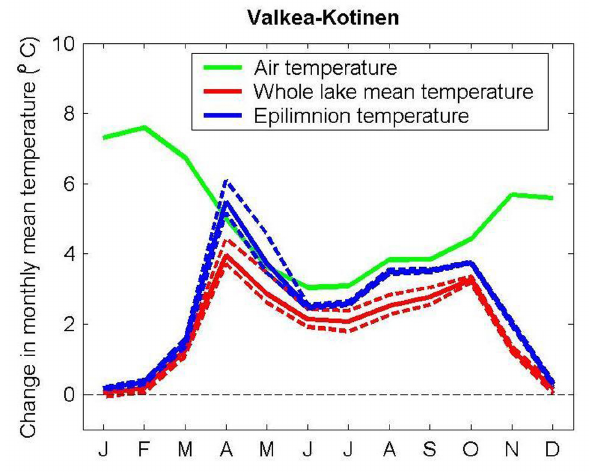
Fig. 3. Simulated change in monthly mean air, whole lake, and epilimnion (0.5m depth) temperatures between control (1961– 1990) and A2 (2071–2100) scenarios with the ECHAM4 forcing in Valkea-Kotinen. The first simulation years 1961 and 2071 are not included in the means. The thick solid lines denote the median, and the dashed lines the 90% credible intervals of the 200 simulations conducted in the uncertainty analysis, where parameter values sets were re-sampled from the parameter chain estimated in the MCMC simulation (modified from Saloranta et al.,